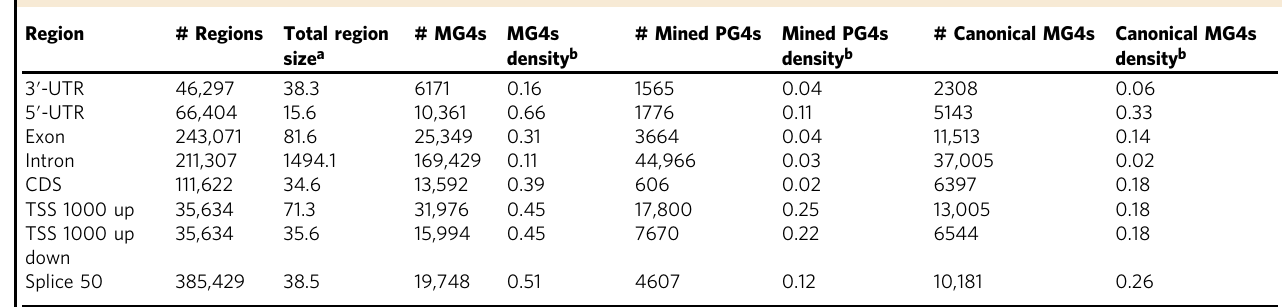
CDS coding region, TSS 1000 up 1000-base upstream of the transcription starting site, TSS 1000 up down 1000-base upstream and downstream of the transcription starting site. a The total length of the speci fi c kind of region (million base